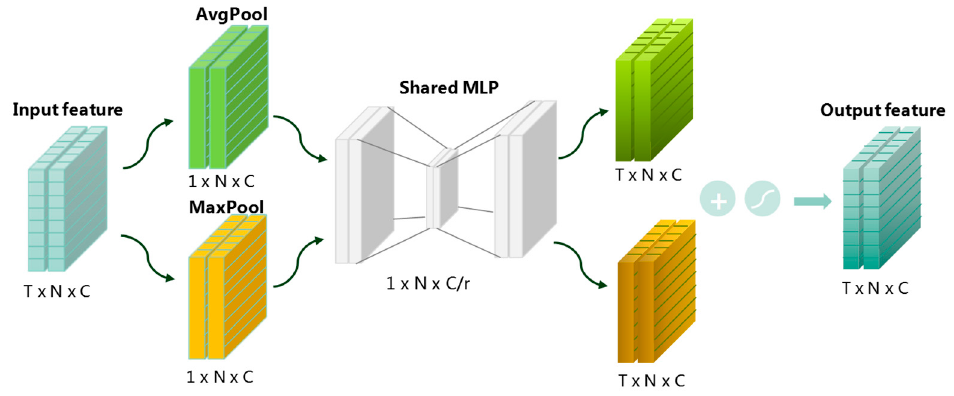
Figure 1. The structure of the temporal information weighting module (TIW).